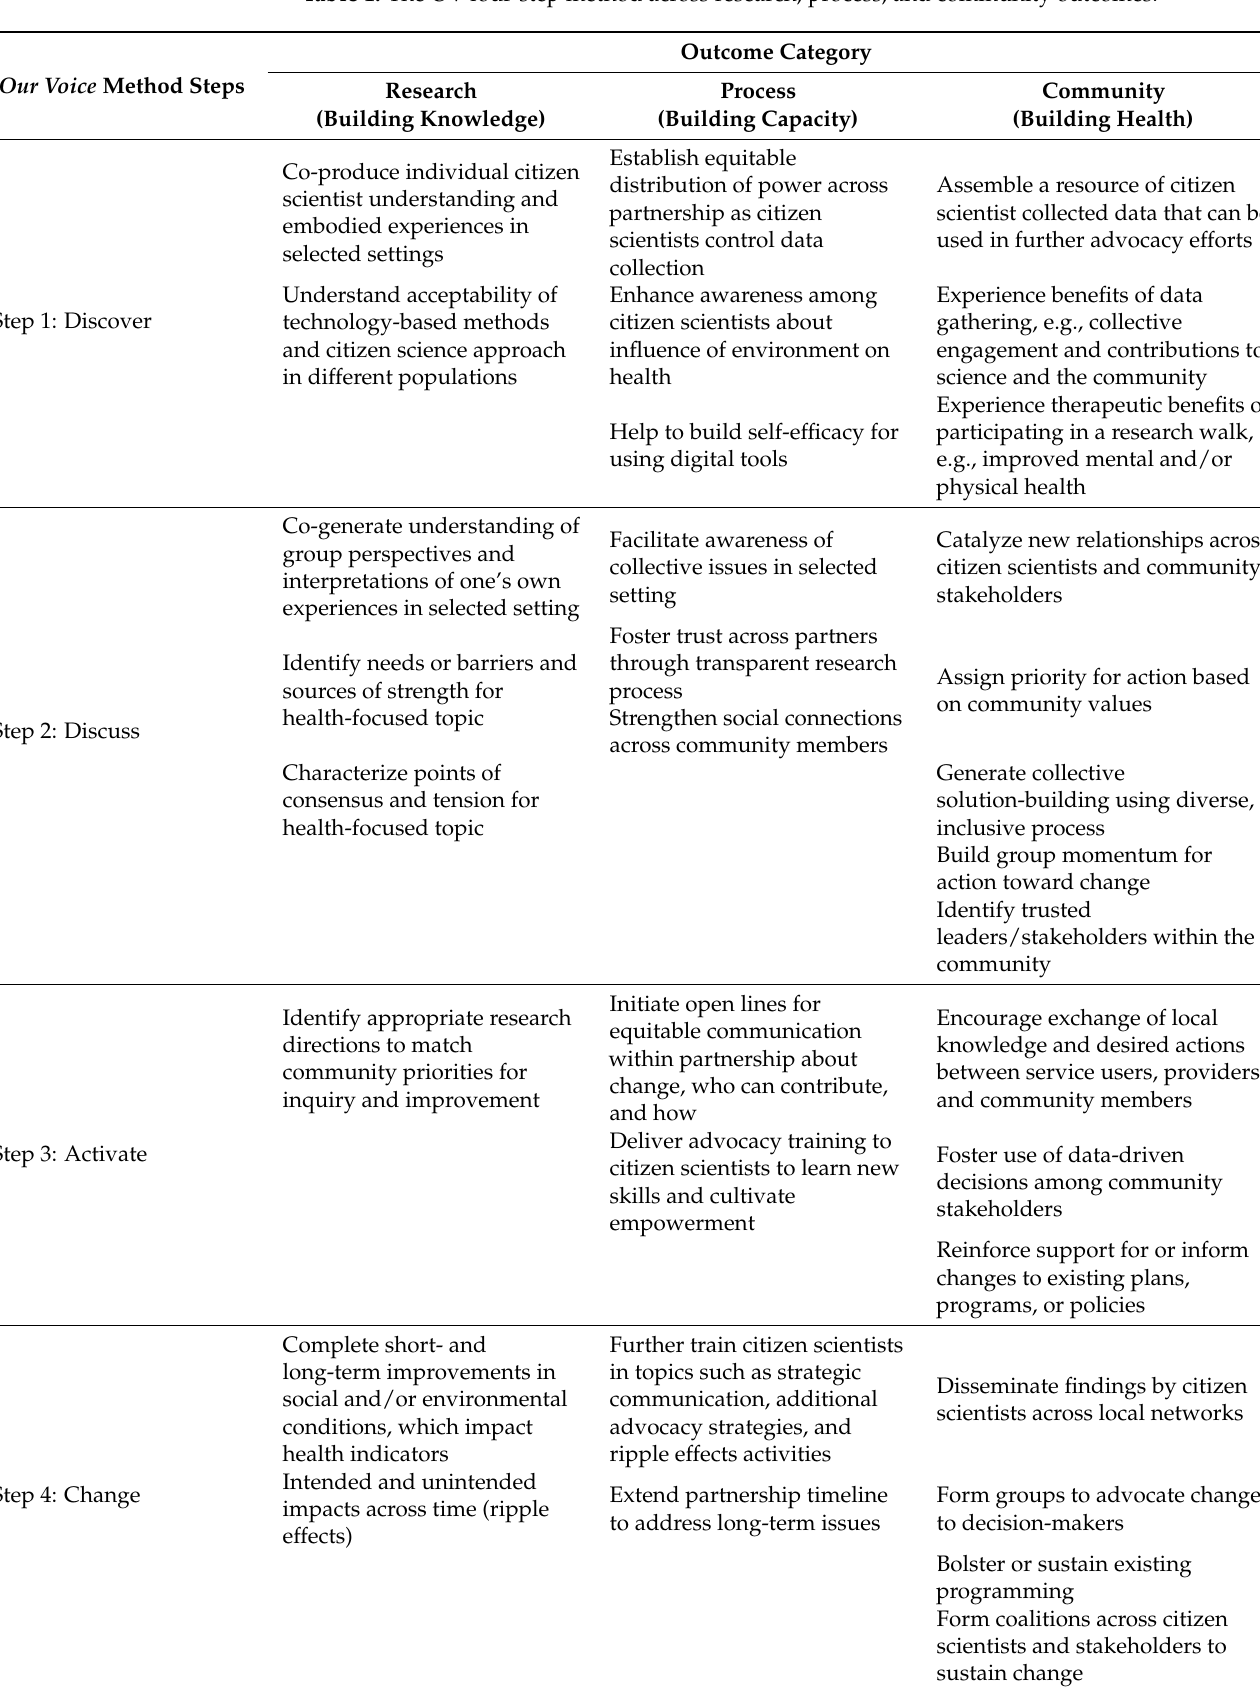
Table 1. The OV four-step method across research, process, and community